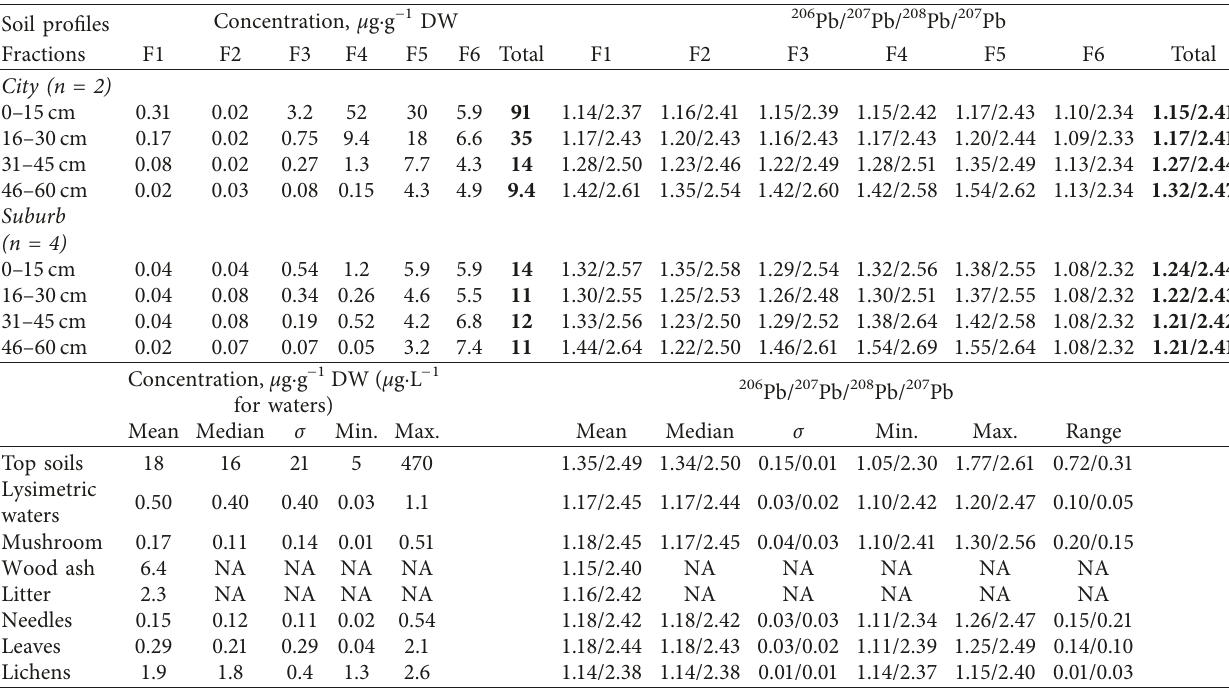
Table 9: Lead concentrations and isotopic composition in environmental samples from Lule˚a. Soil